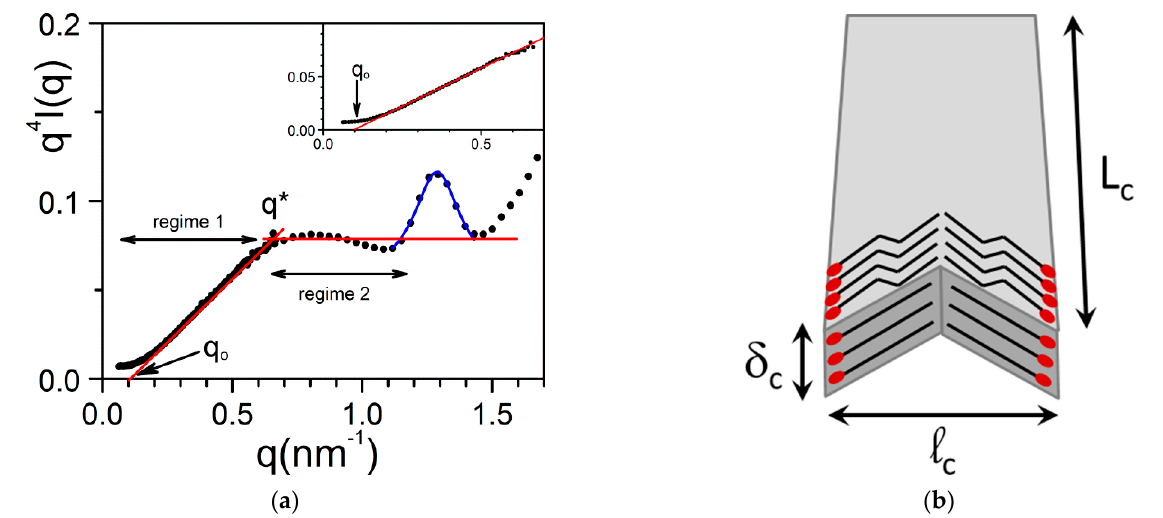
( b ) Figure 13. Scattering patterns plotted by means of a Kratky plot ( q 2 I(q) vs. q ) for: ( a ) SANS, BHPB-10/o-xylene; C = 0.01 g/cm 3 ; red line fit with relation 21. Note the peak is due to the representation, and is therefore not a Bragg peak [38]. ( b ) Scheme 0. C (  ); C = 0.04 g/cm 3 . Here the peak is a Bragg peak as it is also seen in a I(q) vs. q plot. The curves are fitted with relation 16 and the FWHM, Δ q , is shown by double arrows. [39]. The effect of the quenching temperature on the fibril structure can be determined by measuring the peak broadening corresponding to 001 peak for OPVOH/ cis -decahydronaphthalene gels. The scattering profile of the 001 peak changes significantly whether the system is quenched at 0 °C or 20 °C (Figure 13b). The FWHM determined from a fit with the Lorentzian function of relation 16 gives Δ q (0 °C) = 0.63 with ξ = 10 nm against Δ q (20 °C) = 0.19 with ξ = 33 nm. Clearly, the deeper the quench, the